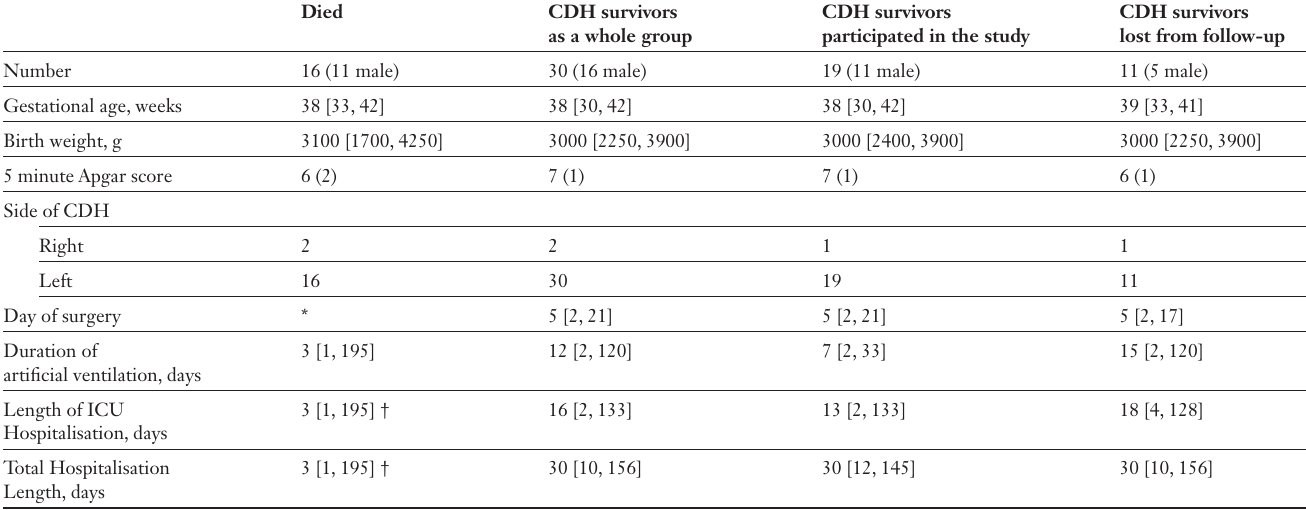
Patient characteristics and initial management according to outcome and to participation in the study. Continuous variables are summarised by either the mean (SD) or the median [range].